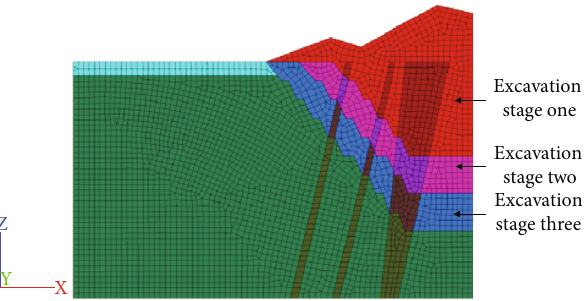
Figure 6: C side slope step-by-step excavation